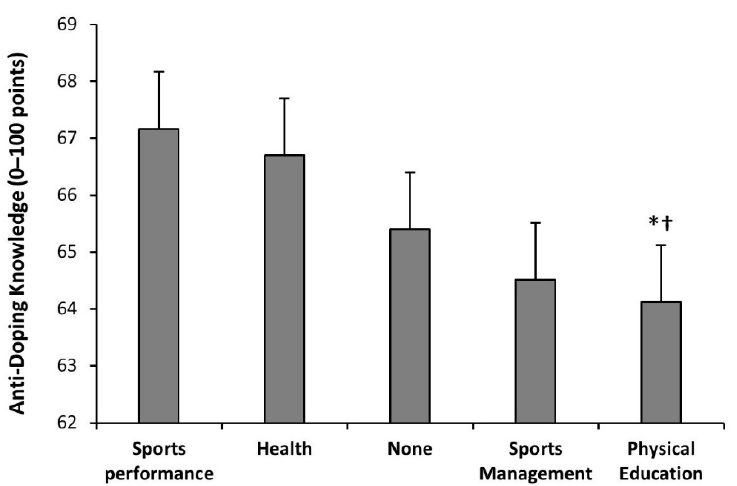
Figure 4. Score in the adapted version of the WADA Play True Quiz of bachelor students undertaking a degree in sports sciences at Spanish universities according to their itinerary. Data for each itinerary are presented as mean ± standard deviation (*) Different from students in the itinerary of sports performance at p < 0.050, identified with Tukey post hoc. (†) Different from students in the itinerary of health at p < 0.050, identified with Tukey post hoc.